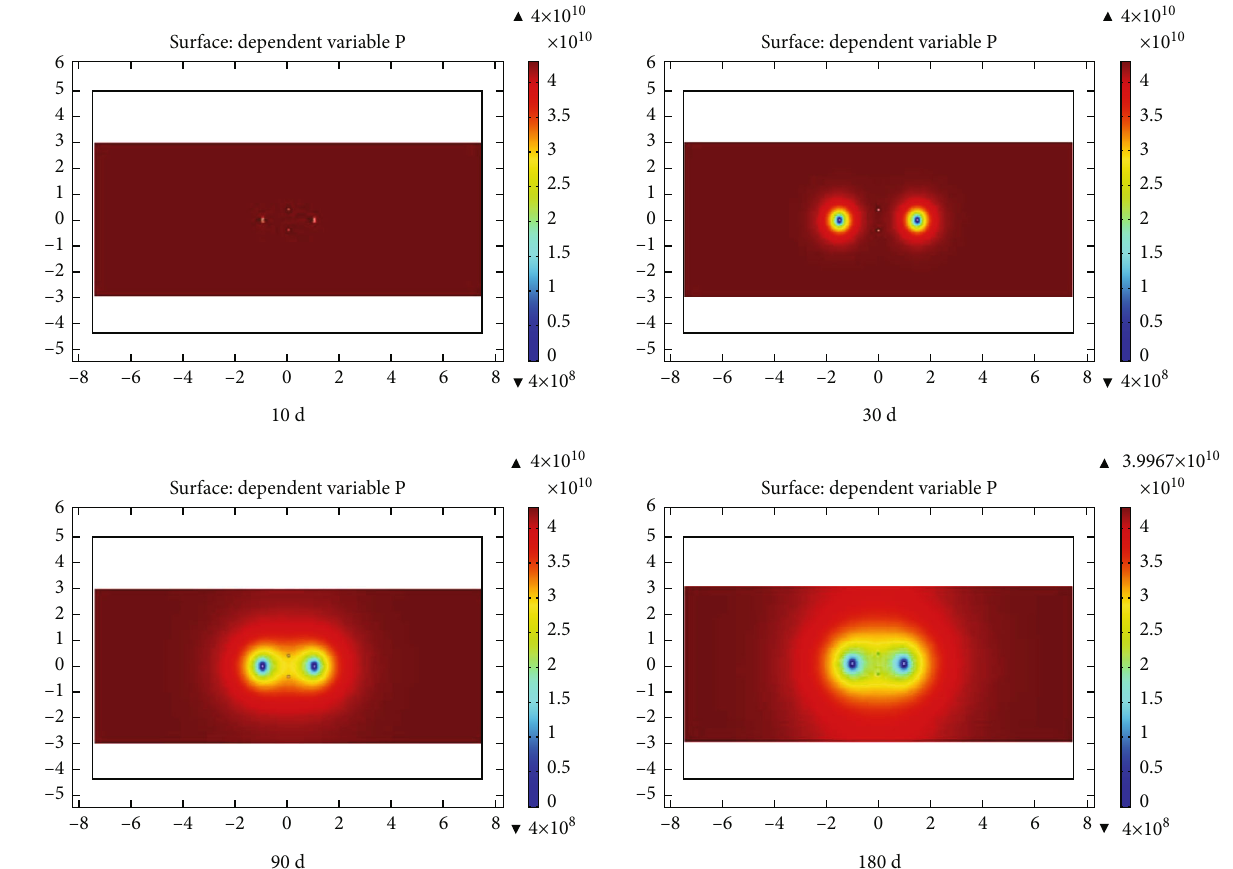
Figure 11: Gas pressure distribution map of two-hole liquid carbon dioxide fracturing with interval of relief e ff ect of double-hole fracturing is signi fi cantly greater than that of single-hole fracturing. In the early stage of extraction, the pressure relief area of the two extraction holes was circular and gradually evolved into “ ∞ ” distribution after 30 days. The pressure relief e ff ect near the side of the fracturing hole was more obvious.